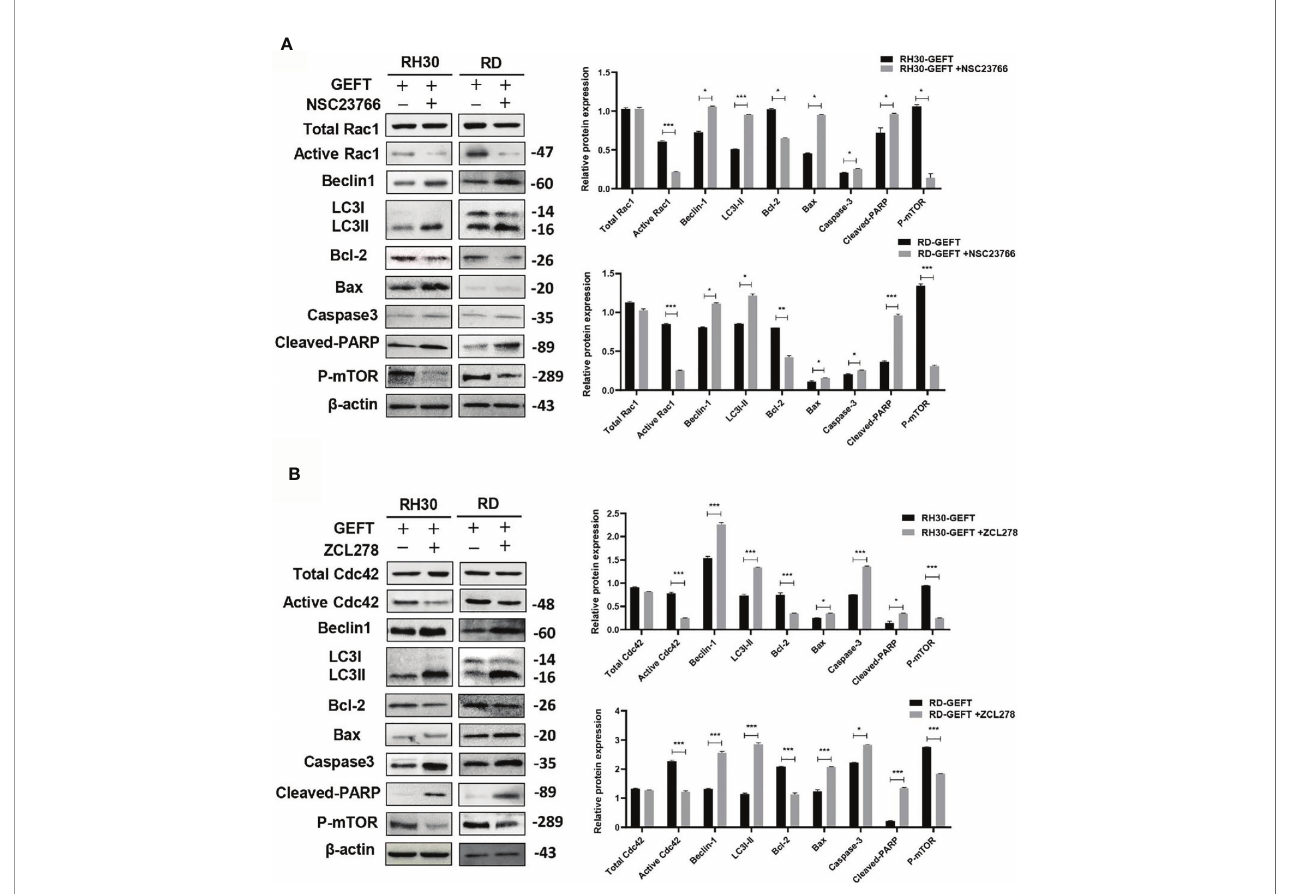
FIGURE 7 | GEFT-mediated Rac1 and Cdc42 inhibit the expression levels of autophagy- and apoptosis-related proteins in transplanted tumor tissues. (A, B) Western blot was used to detect the expression of Total Rac1, Active Rac1, Total Cdc42, Active Cdc42, p-mTOR, Beclin1, LC3, Bax, Bcl-2, caspase-3, and cleaved-PARP in RH30 and RD cells transfected with the GEFT group after the addition of Rac1 (A, B) Cdc42 inhibitors. *** P < 0.001, ** P < 0.01, * P <